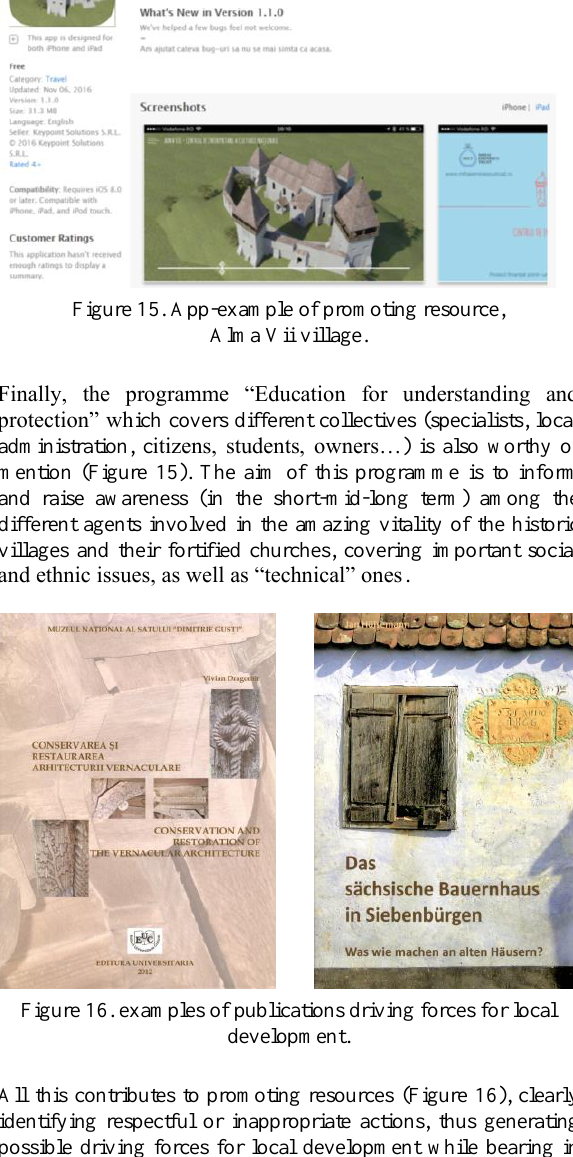
Figure 14. Examples of inappropriate actions stressed by management plan.